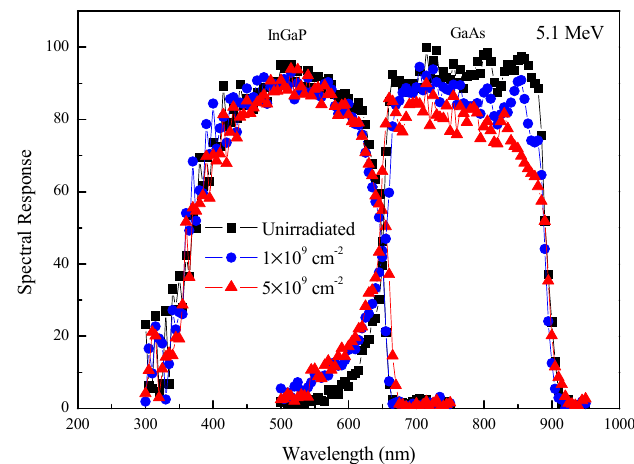
Figure 3. Spectral response of the InGaP top cells and GaAs middle cells before and after 5.1 MeV alpha-particle irradiation with various fluences.